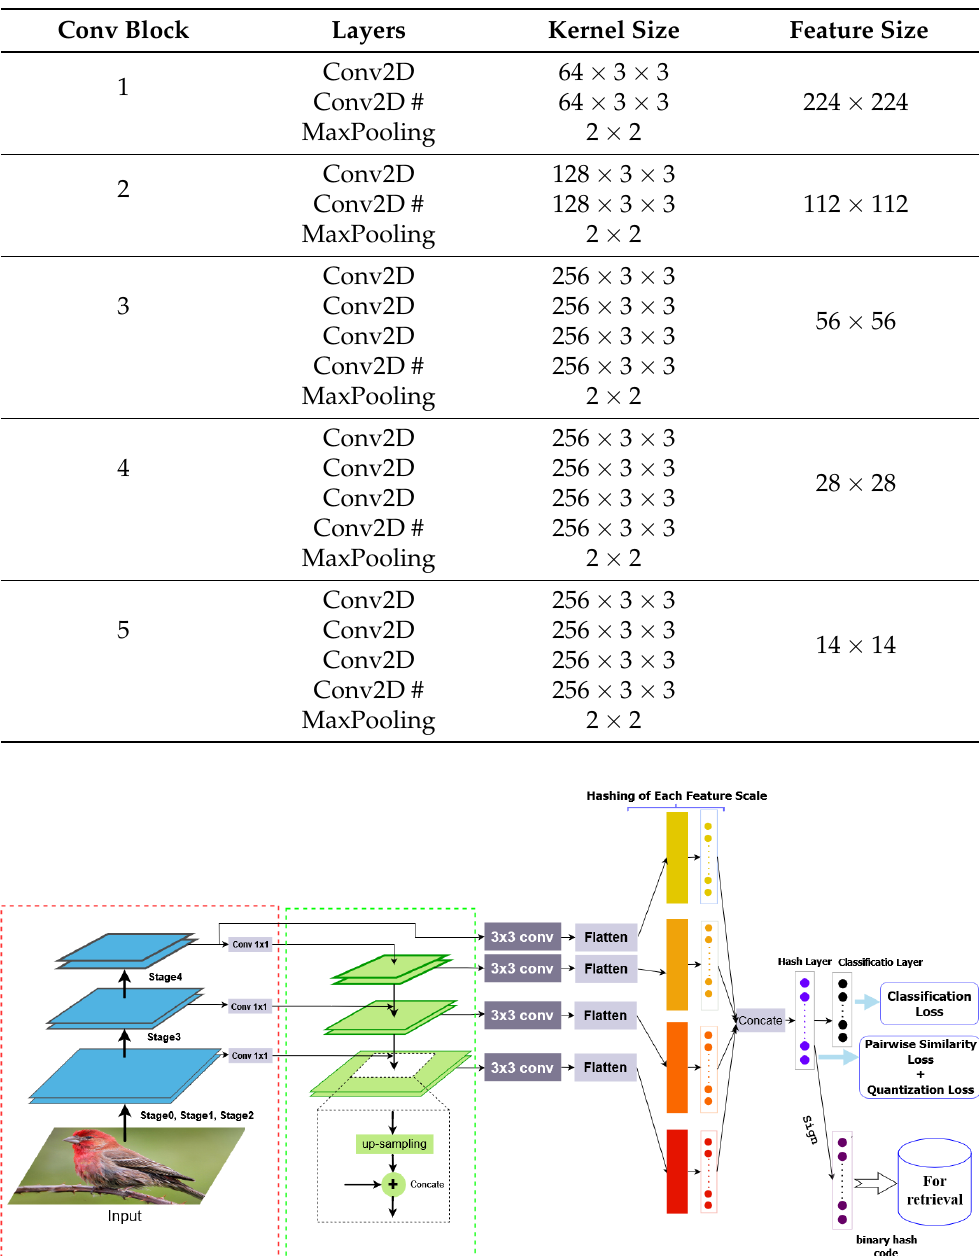
Table 1. Details of the feature extraction network. Note that we use the features of the layers marked by “#”. For simplicity, we omit ReLU and Batch Normalization layers. Conv Block